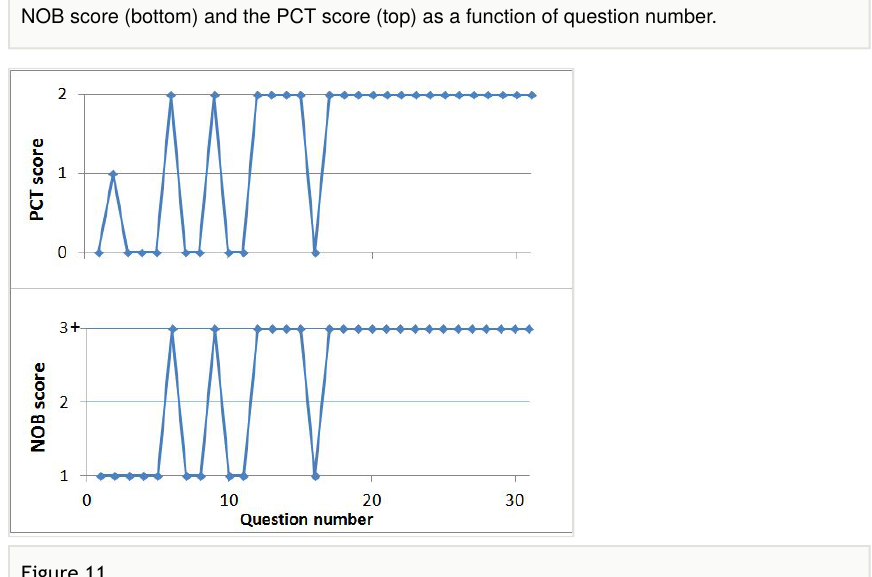
Graphical representation of neurobiological requirements for WISC-V, Visual Puzzles. The NOB score (bottom) and the PCT score (top) as a function of question